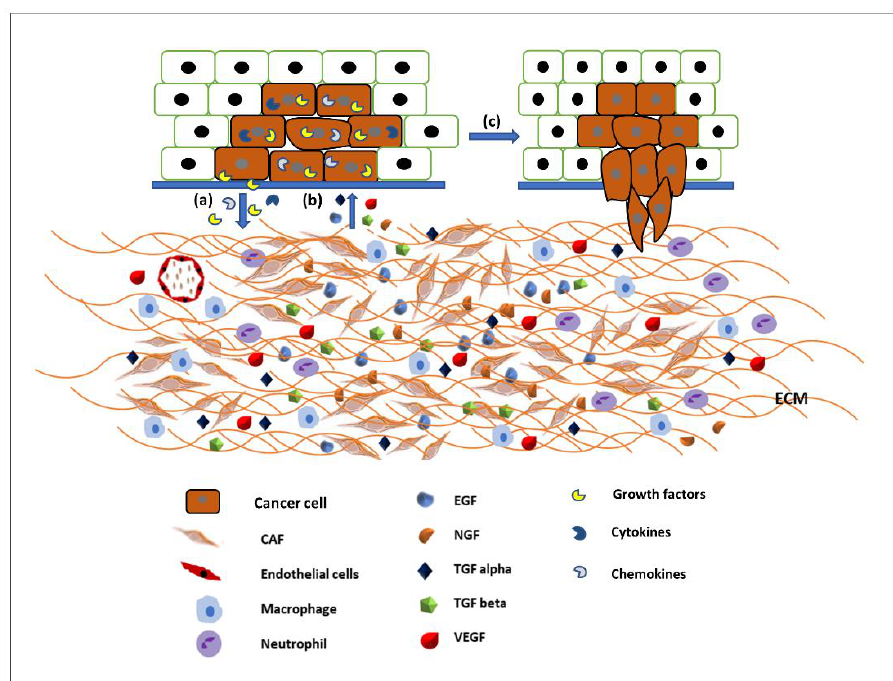
Figure 2. Communication between the tumour microenvironment and tumour cells. (a) Tumour cells release various growth factors, cytokines, and chemokines to recruit stromal cells, immune cells, and vascular cells. (b) Recruited cells then proliferation and overexpress growth factors such as EGF, TGF α and β , VEGF, NGF, etc., to initiate signalling pathways in tumour cells. (c) Activated signalling pathways then trigger various cellular activity such as tumour cell proliferation and migration and invasion.